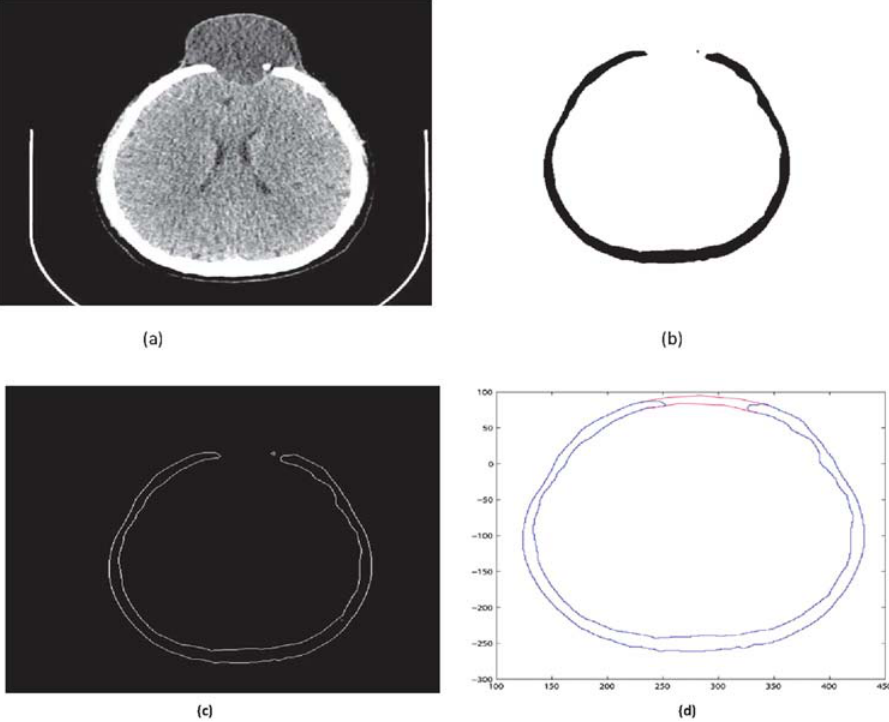
Fig 5. CT scanned data of slice 160. (a)Original image (b) Binary image (c) Boundary (d)Reconstructed missing part using rational cubic